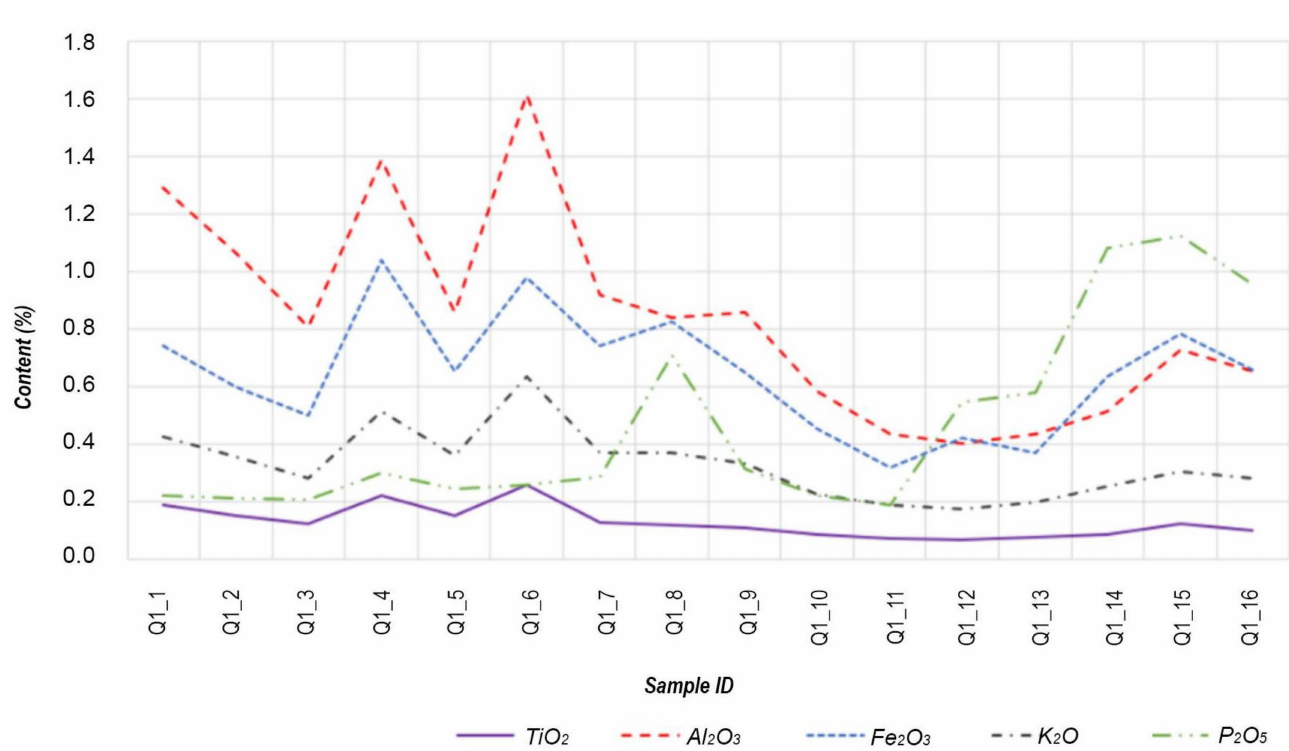
Figure 8. Variations in TiO 2 , Al 2 O 3 , Fe 2 O 3 , K 2 O and P 2 O 5 . Analysis of samples from Mqabba quarry and church converge to similar